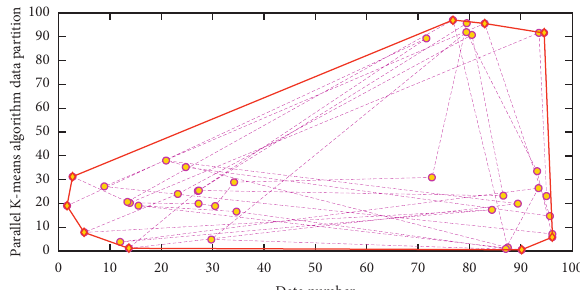
Figure 5: Parallel K-means algorithm data